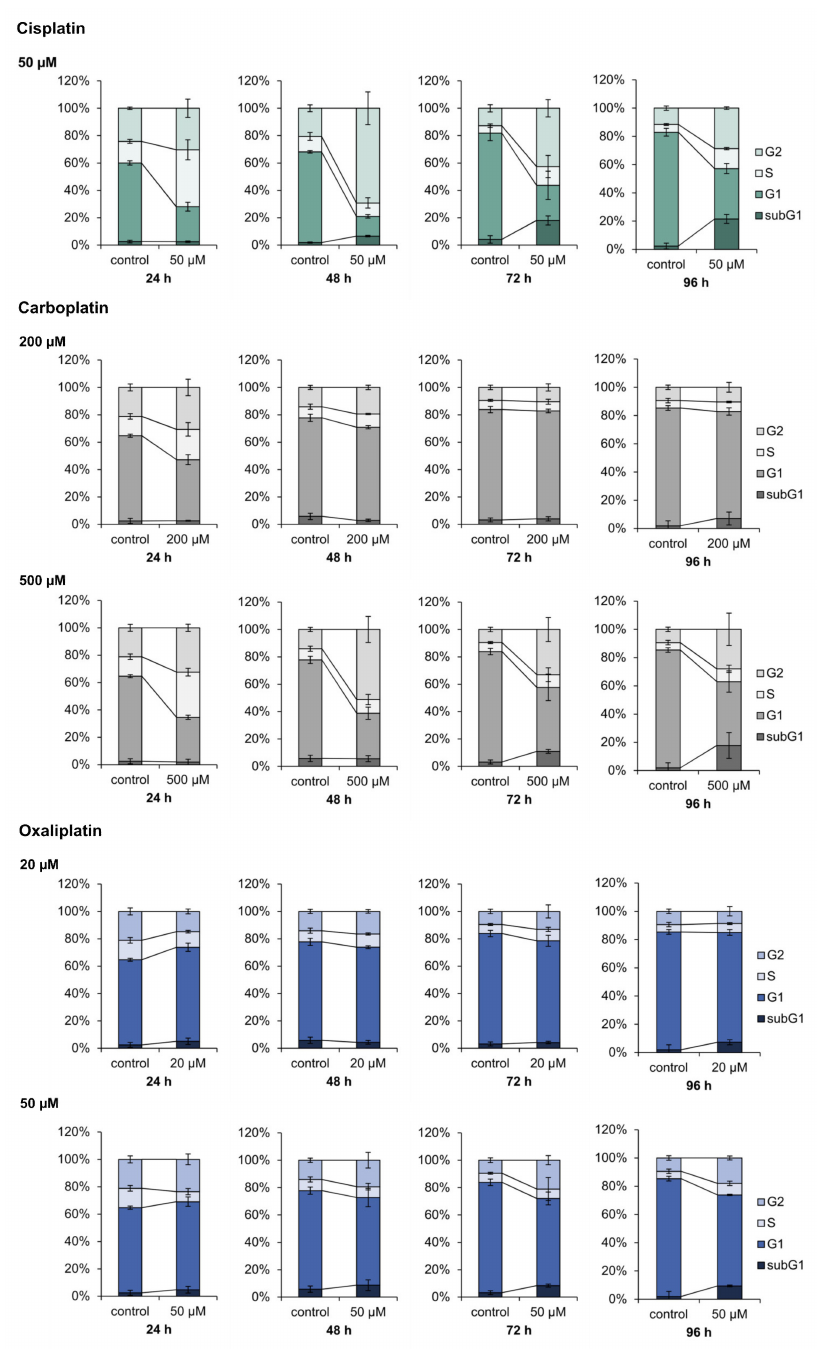
Figure 7. Analysis of the cell cycle distribution of A498 cell after treatment with cisplatin, carboplatin or oxaliplatin. Cells were incubated for 1 h with cisplatin (50 µ M), carboplatin (200, 500 µ M) or oxaliplatin (20, 50 µ M) followed by postcultivation of 24, 48, 72 or 96 h. Cell cycle distribution was analyzed by DAPI (4 (cid:48) ,6 (cid:48) -diamidino-2-phenylindole) staining via flow cytometry. The mean values are shown of three independent experiments of the percentage distribution of the cell cycle phases ± standard deviation. The data for cisplatin are taken from